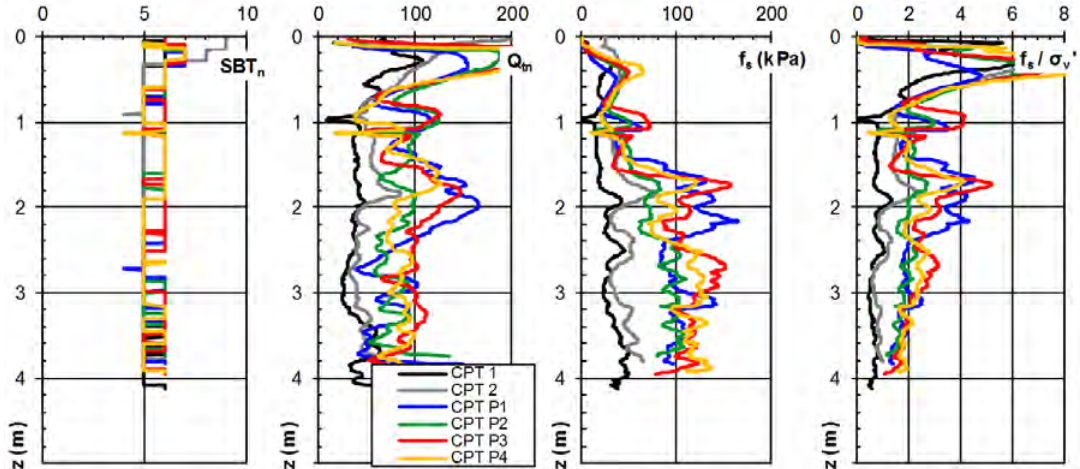
Figure 14. Results of CPT tests. CPT 1 and CPT 2 before RIC, CPT P1 to CPT P4 after RIC performed on sub-fields P1 to P4 (tests performed by IRGO, [19]).